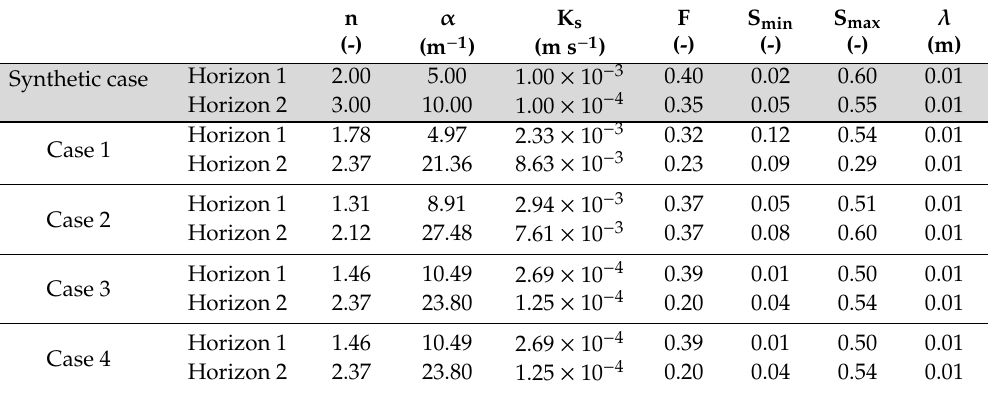
Table 2. Comparison of soil hydraulic parameters obtained using di ff erent types of data in the optimization procedure. The set of reference parameters is the “synthetic case”. To calibrate the model, the other cases rely on one water content profile at a single time (case 1); one water content profile and one pore water isotope composition profile at a same single time (case 2); monthly monitoring of the water content and pore water isotope composition at a 15 cm depth, plus one water content and one pore water isotope composition profile at a single time (case 3); and daily water content monitoring at 10, 20, 50, and 100 cm depths, plus one water content and pore water isotope composition profile at a single time (case